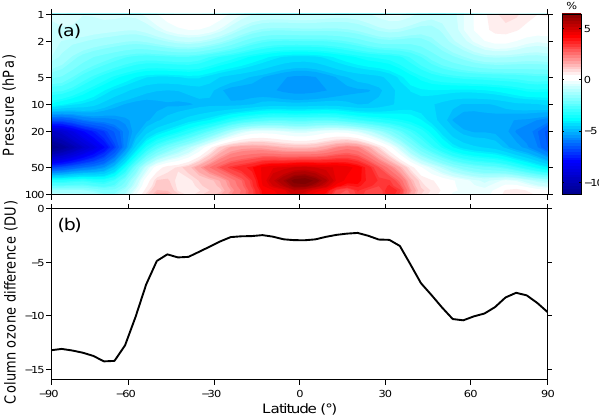
Fig. 5. (a) N 2 O-8.5 ozone minus N 2 O-2.6 ozone in the 2090s decade, calculated as a percentage of ozone in the N 2 O-2.6 simula- tion. (b) 2090s-decade N 2 O-8.5 total column ozone minus N 2 O-2.6 total column Latitude (°) − 3 ) in the 2090s decade 1 Fig. 4. (a) NO x abundance (moleculescm for the N 2 O-8.5 simulation, minus the same quantity for the N 2 O- 2.6 simulation. (b) The quantity in (a) expressed as a percentage of 2090s NO x abundance for the N 2 O-2.6 simulation. (c) Abundance of water vapour (moleculescm − 3 ) in the 2090s decade for the CH 4 - 8.5 simulation, minus the same quantity for the CH 4 -2.6 simulation. (d) The quantity in (c) expressed as a percentage of 2090s water vapour abundance for the CH 4 -2.6 simulation.